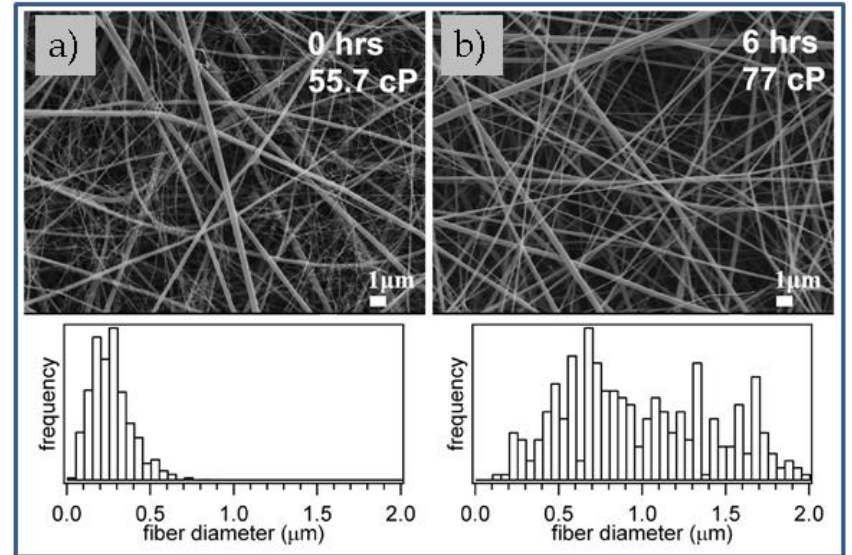
Figure 3. Representative SEM images and fiber diameter distributions of electrospun DMB fibers from a 7:3 mixture of 1,1,1,3,3,3-hexafluoroisopropanol/trifluoroacetic acid mixture processed immediately after dissolution ( a ) or after 6 h ( b ). Reproduced with permission from [66], American Chemical Society, 2014.